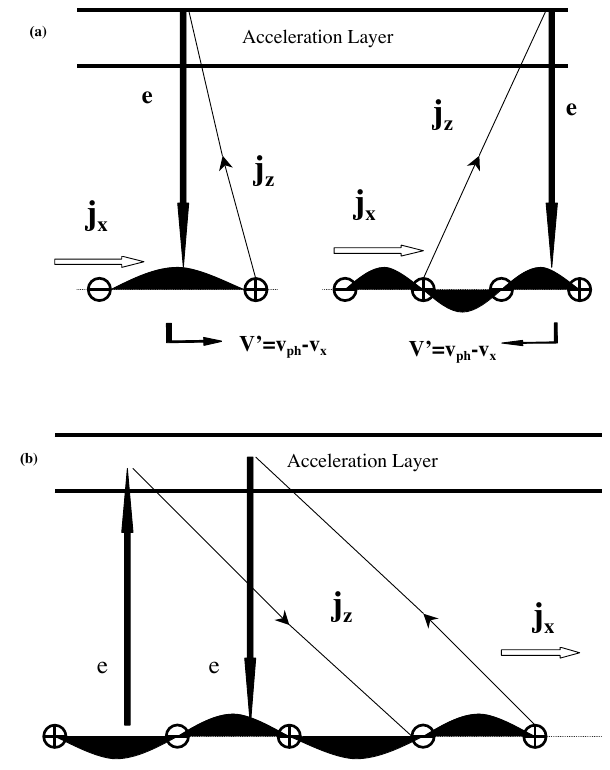
Fig. 3. A scheme explaining the generation of a single arc-like structure (a) , and multiple periodic structures (b) . v is the relative velocity of the structures in the coordinate system moving at the E × B drift